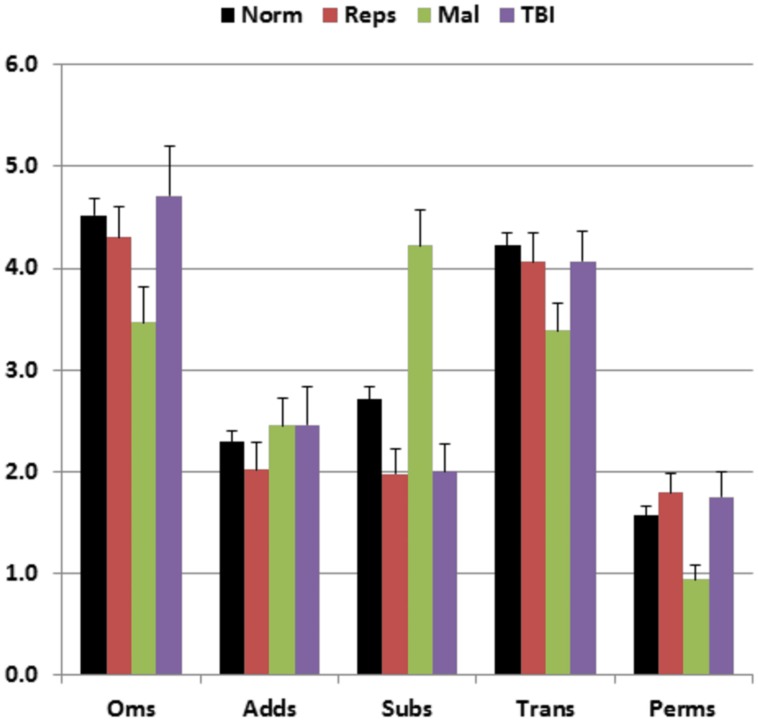
Percentage of errors of different types made by participants of different groups. Oms, omissions; Adds, additions; Subs, substitutions; Trans, transpositions; Perms, permutations. Error bars show standard errors. See Figure 2 for group membership specifications.